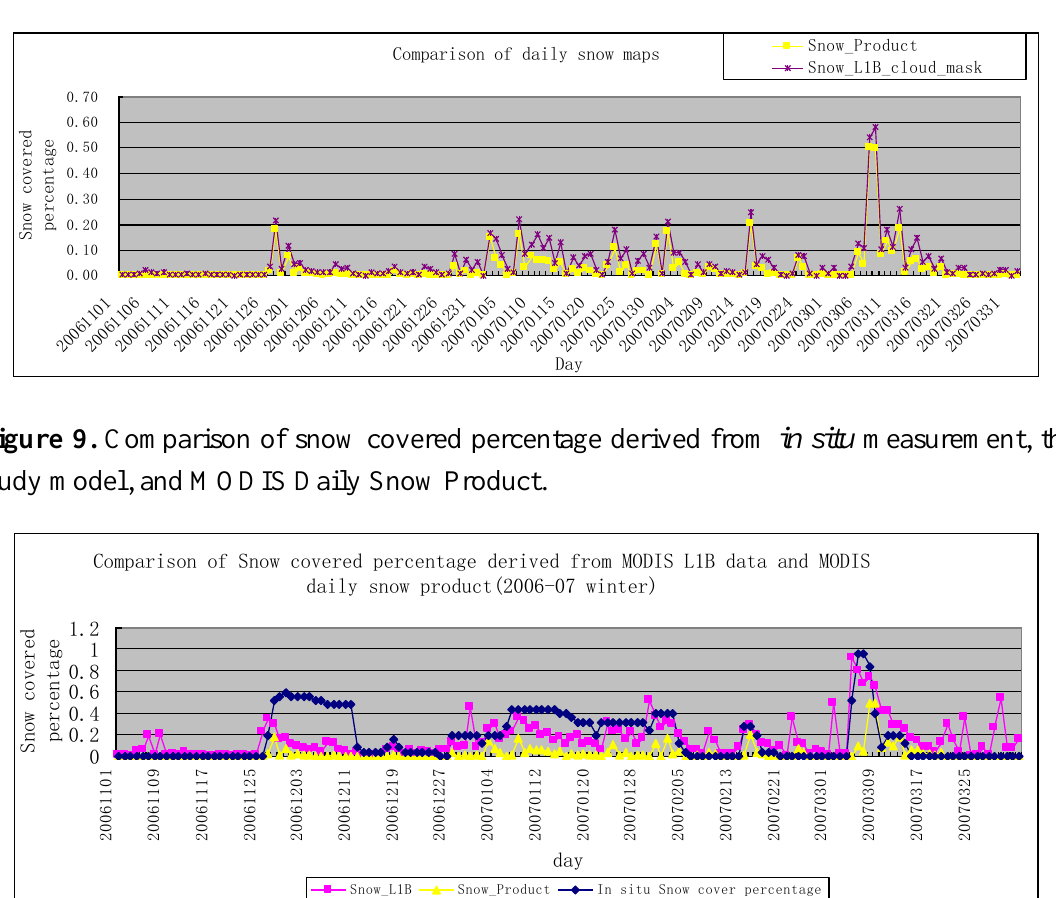
Figure 8. Comparison of daily snow maps of MODIS Snow Product and snow cover derived from cloud masked MODIS L1B.